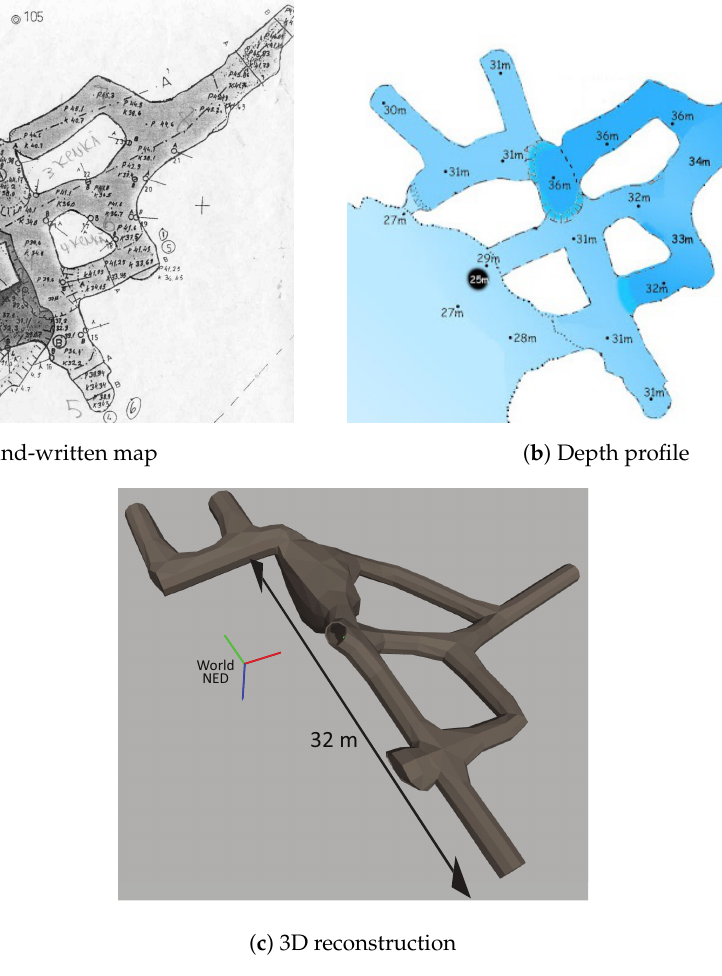
Figure 8. Kaatiala mine, Finland.